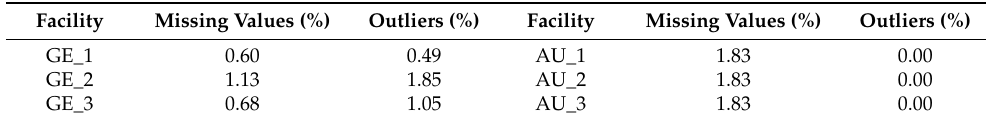
Table 3. Missing values and outliers detected in each